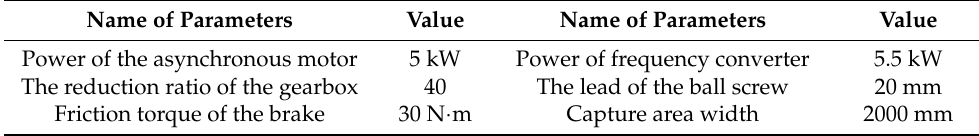
Table 3. The parameters of the transmission system.